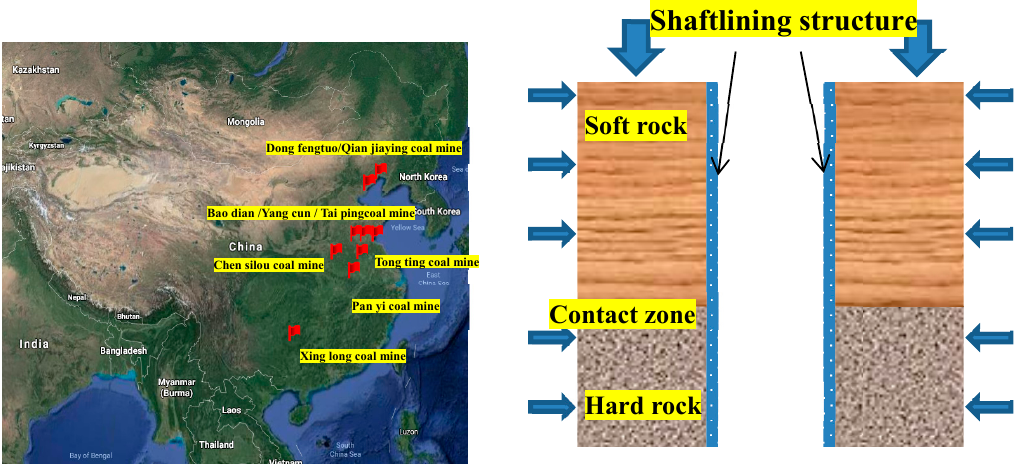
Figure 1. Schematic image of stress in shaft.